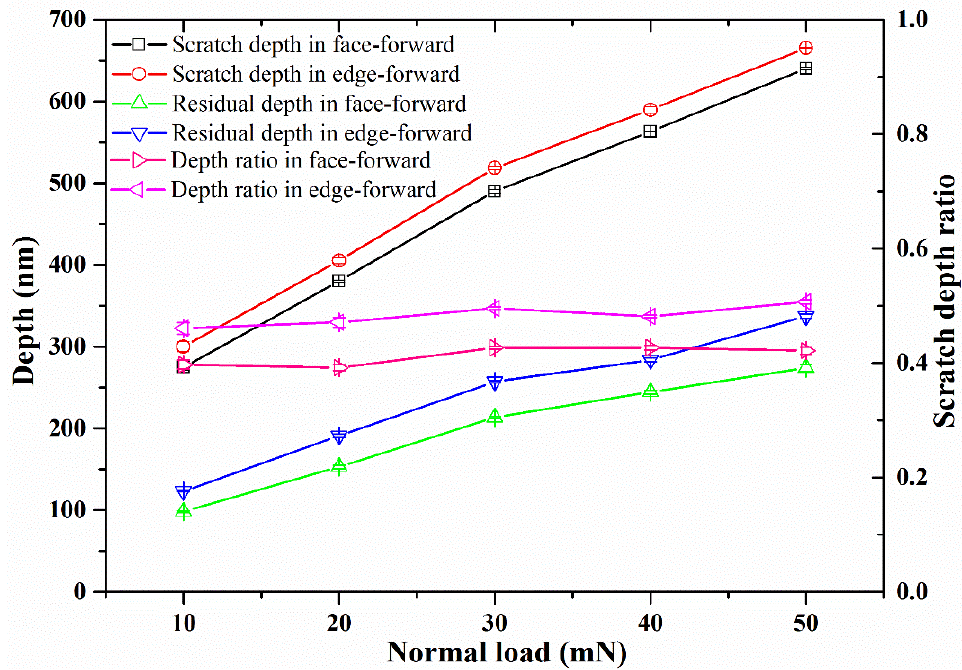
Figure 4. Scratch depth, residual depth, and depth ratio curve under different scratch directions.